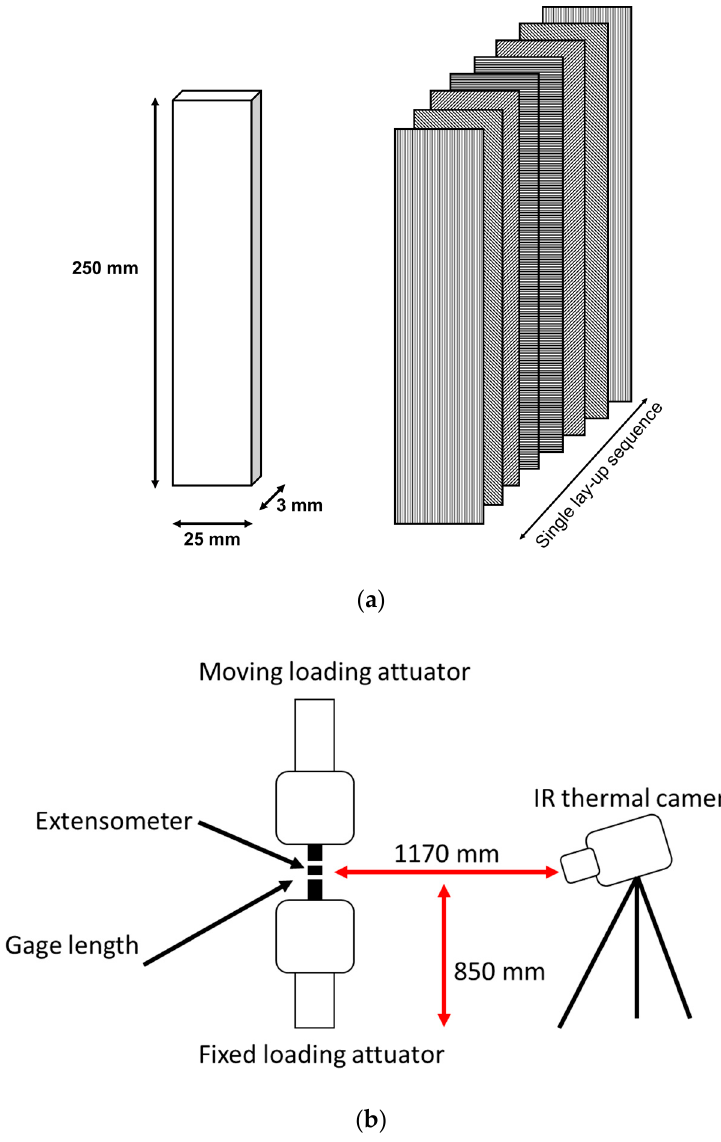
Figure 1. ( a ) sample geometry and dimensions, ( b ) setup and equipment.